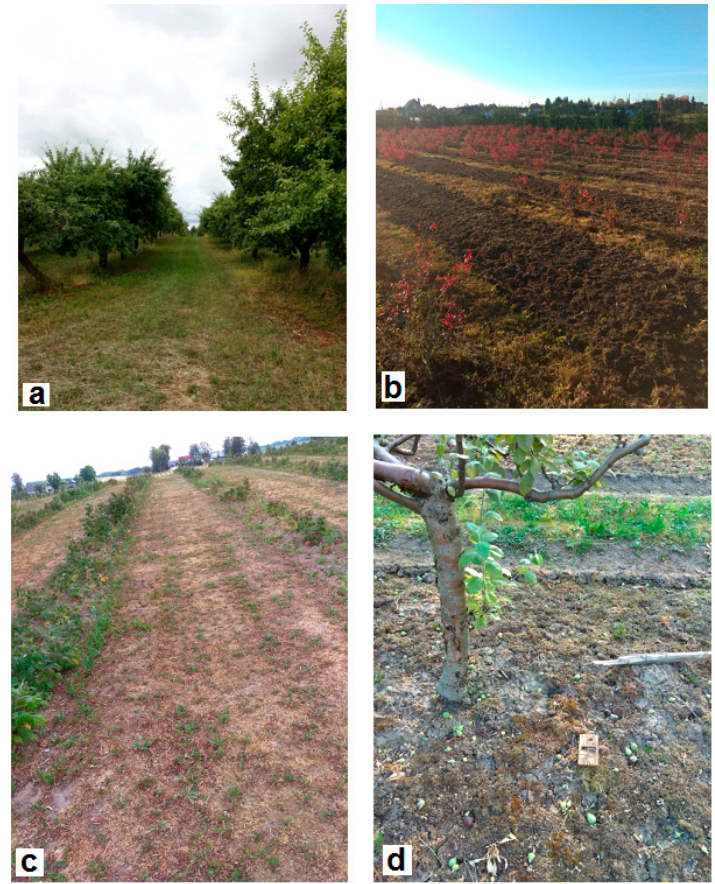
Figure A1. Research sites with high farming intensity: ( a ) apple fruit farm at site 6; ( b ) highbush blueberry at site 13; ( c ) raspberry plantation at site 10; and ( d ) apple fruit farm at site 15.